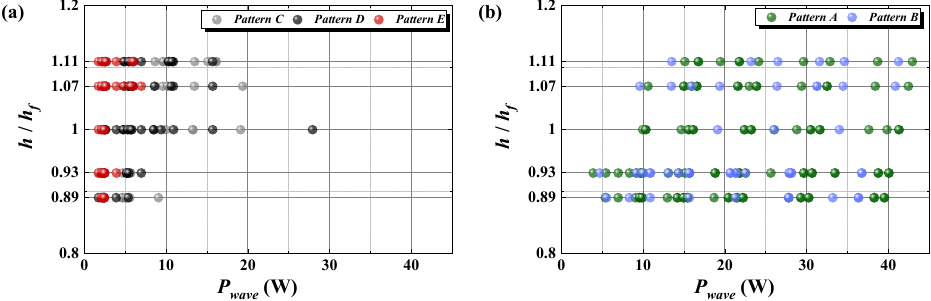
Figure 9. Effects of h and P wave on the behavior of the flap: ( a ) patterns C (unstable), D (loss), and E ( P wec = 0); ( b ) patterns A (stable) and B (fluctuation). The results in the range of 0.45 < D / L < 0.58 were excluded.